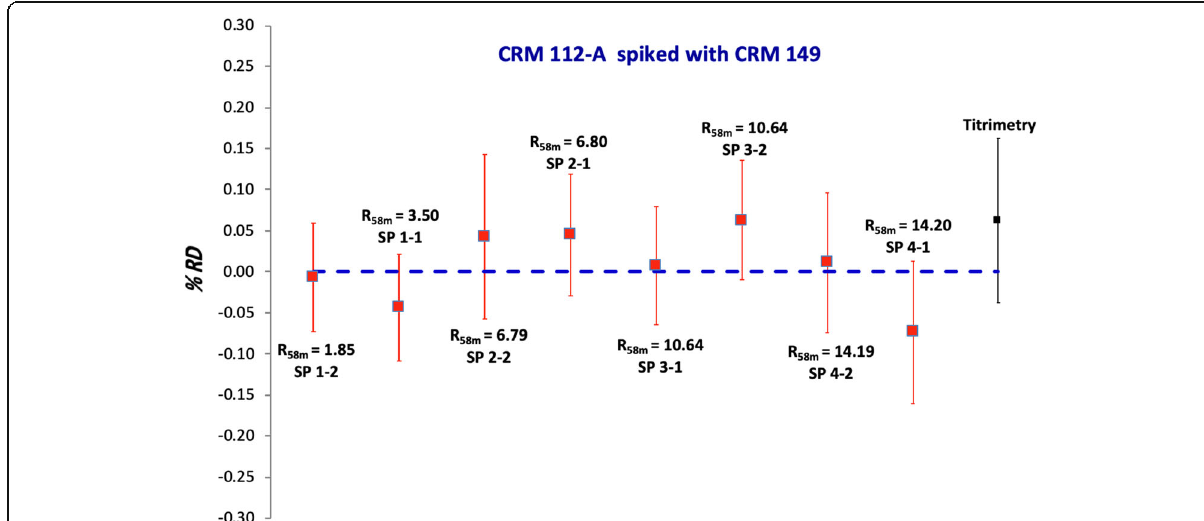
Fig. 1 Relative deviations calculated for the elemental uranium content in CRM 149 sample (treated as unknown) using the CRM 112A original and diluted spikes. Relative deviations are given in percentage in the order of R ( 235 U/ 238 U) mixture ratios increase. (RD% = 100 × ( C usample / C usimulated −